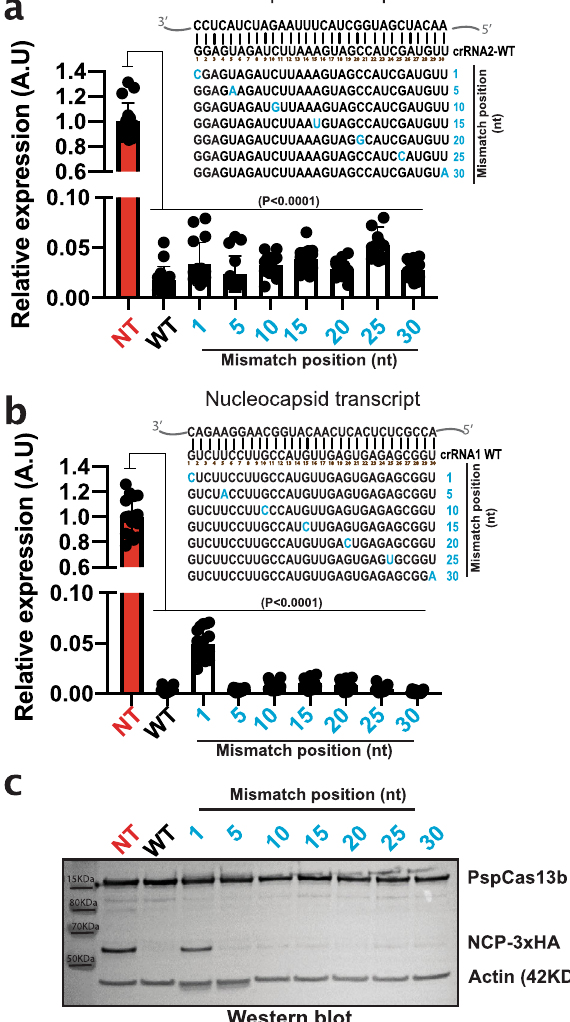
Fig. 3 pspCas13b silencing tolerates single-nucleotide mismatch with SARS-CoV-2 targets. Fluorescence-based reporter assays to assess the silencing ef fi ciency of Spike ( a ) or Nucleocapsid ( b ) transcripts with crRNAs harbouring single-nucleotide mismatch at various location of the spacer-target interface 48 h post-transfection. Nucleotides in blue highlight the mismatch position. Data points in the graphs are mean fl uorescence from 4 representative fi elds of view per condition imaged; N = 4. The data are represented in arbitrary units (A.U.). Errors are SD and p-values of one- way Anova test are indicated (95% con fi dence interval). c Representative Western blot analysis to examine the expression level of Nucleocapsid protein (3xHA tagged) in HEK 293 T cells expressing NCP-1 crRNA with single-nucleotide mismatch at various positions of the spacer-target interface 24 h post-transfection; N = 3. (See uncropped blots from 3 independent biological experiments in Source fi le). N is the number of independent biological replicates. Source data are provided as a Source data fi